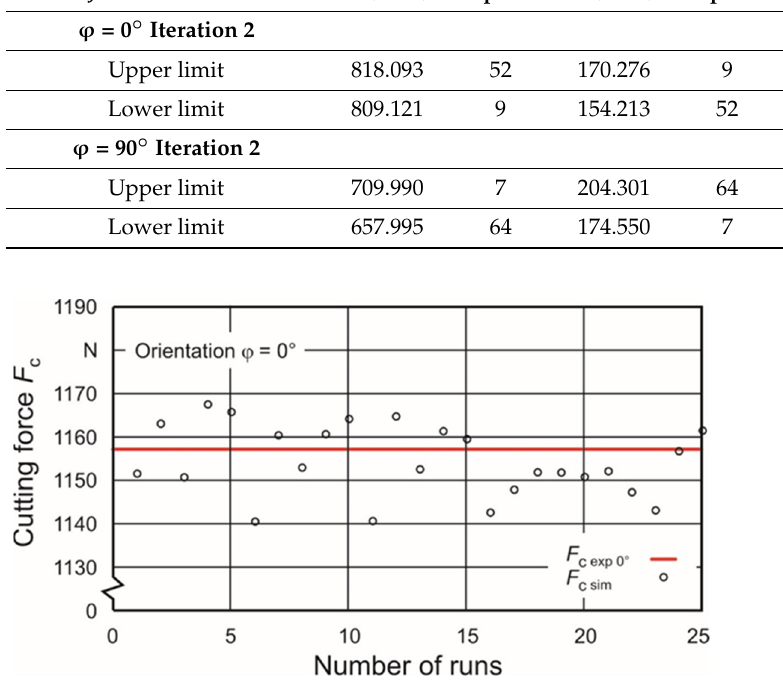
Table 5. Second Iteration With 25 Runs Each Between the Upper and Lower Limit for Orientation Angles φ = 0° and 90°.